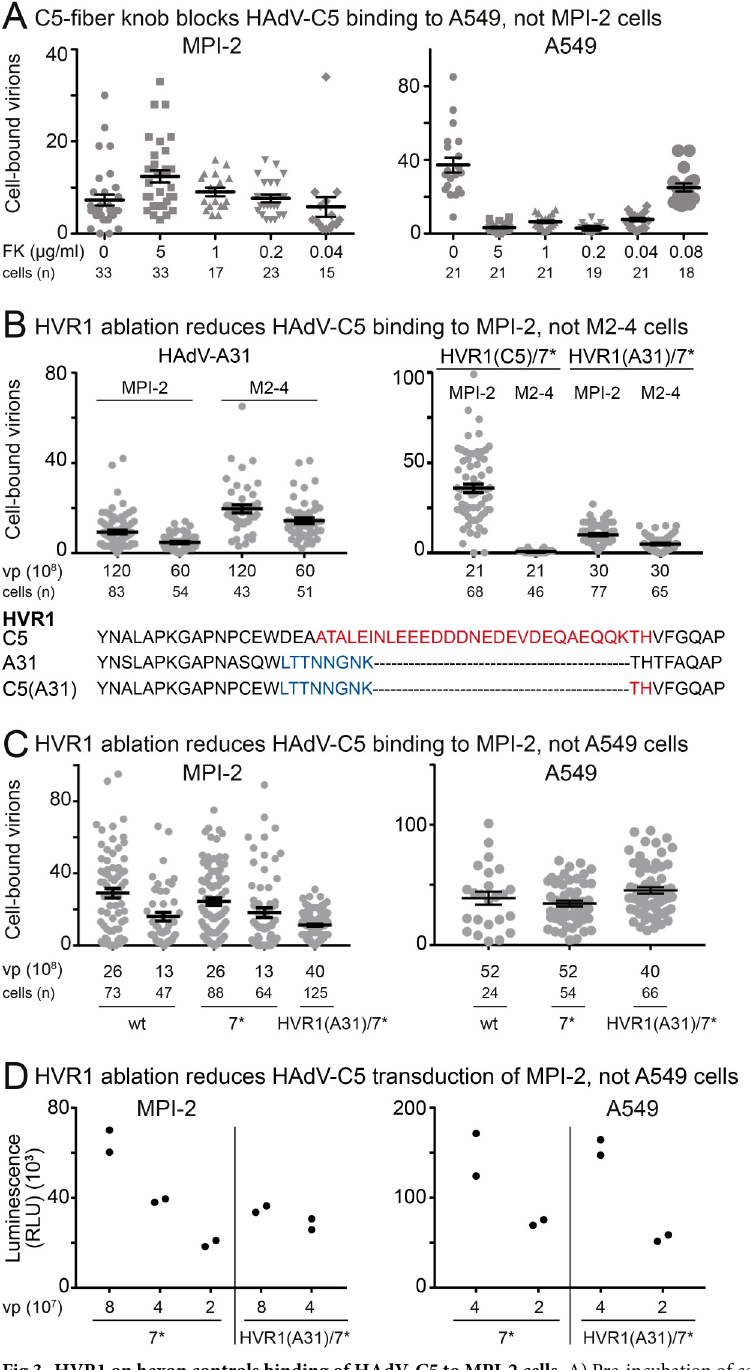
Fig 3. HVR1 on hexon controls binding of HAdV-C5 to MPI-2 cells. A) Pre-incubation of cells with soluble HAdV-C5 fiber knobs (FK) does not inhibit binding of HAdV-C5 to MPI-2 cells, whereas binding of the virus to the CAR-positive A549 cells is suppressed in a dose-dependent manner. Cells were first pre-incubated with the indicated amounts of FKs and Atto565-labeled HAdV-C5 was then added to the cells at 4˚C for 60 min (moi ~ 20000 and 38000 virus particles/cell for MPI-2 and A549, respectively). After removal of unbound viruses and fixation, cells were imaged by confocal microscopy and cell-associated virus particles were scored from maximum projections of confocal stacks. The plot shows number of bound virus particles per cell, one dot representing one cell. Error bars represent the means ± SEMs. Number of cells analyzed is indicated. The difference between MPI-2 FK 0 and 5 μg/ml or 1 μg/ml samples was statistically significant (P = 0.002 and P = 0.032, respectively, Kolmogorov-Smirnov test). B)